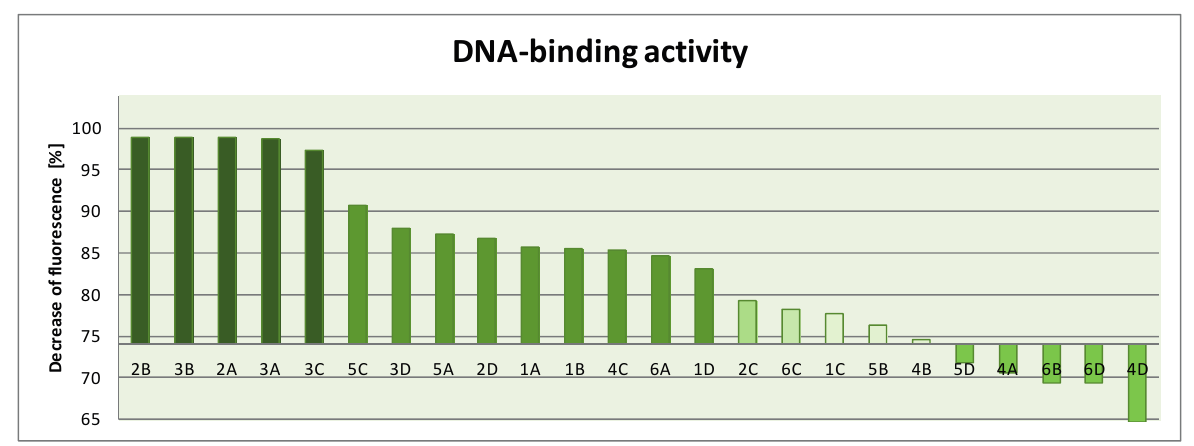
Figure 5. NA-binding activity of compounds 1 – 24 .